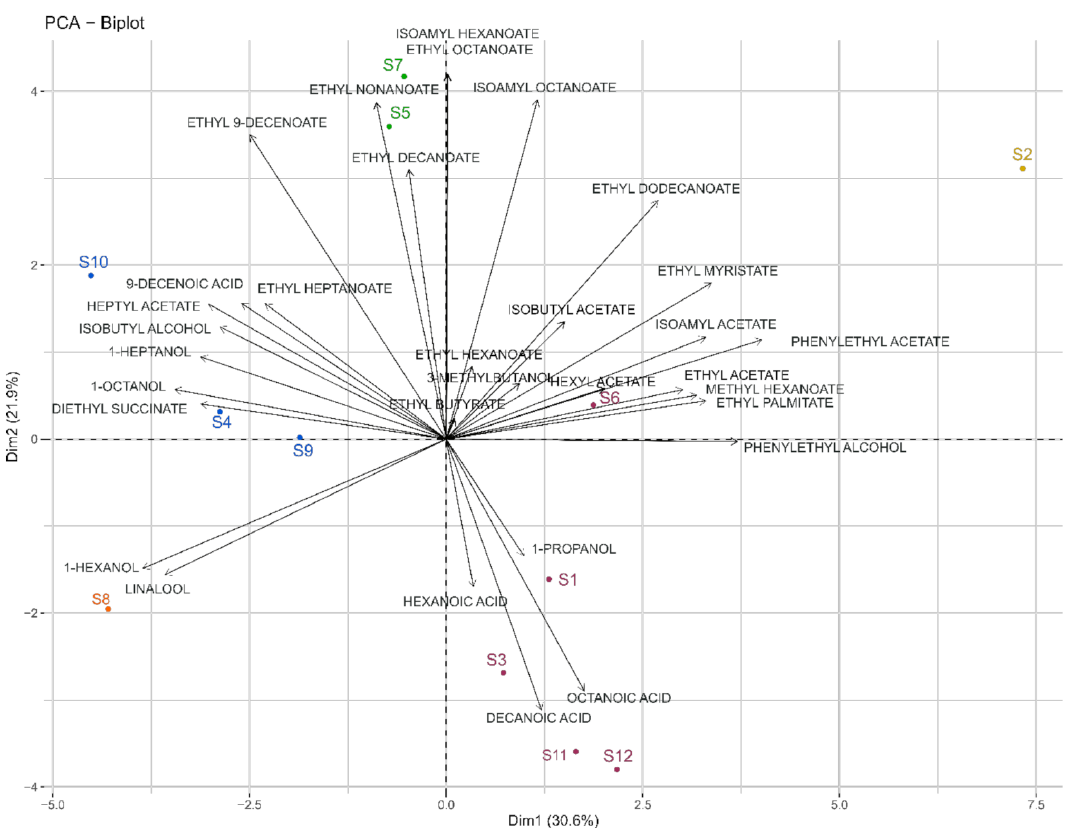
Figure 3. Biplot of PCA (Dim1 vs. Dim2) analysis applied to significantly different volatile compounds found in the twelve fermentations carried out by the different strains of Saccharomyces cerevisiae . Colored samples represent different classes obtained from